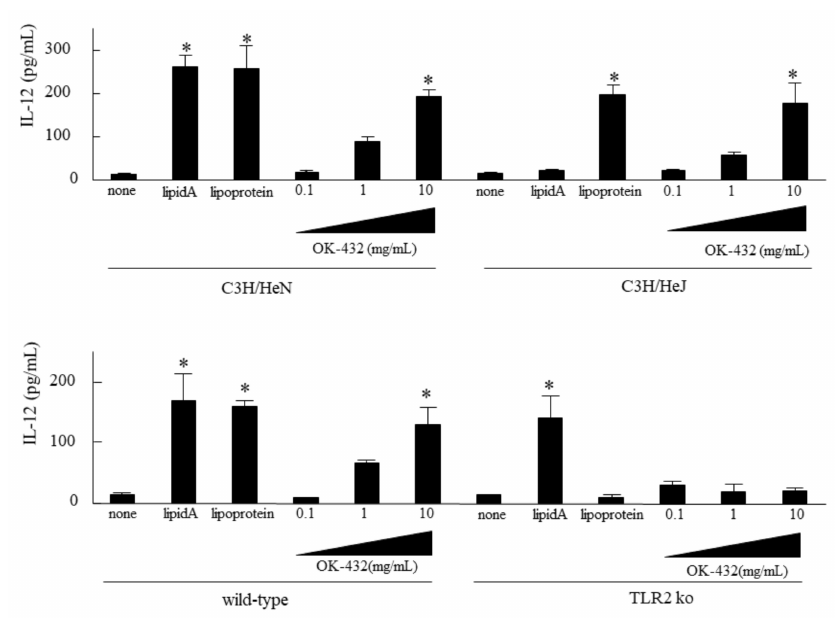
Figure 1. IL-12 production by splenic macrophages from C3H/HeN, C3H/HeJ, wild-type or TLR2 ko mice in response to OK-432. The macrophages from the spleen of C3H/HeN, C3H/HeJ, wild-type or TLR2 knock-out mice were cultured in the presence of lipid A, lipoprotein or OK-432 for 48 h at 37 ◦ C. IL -12 production by macrophages was measured by an ELISA. The data are representative of four independent experiments using pooled cells from five mice and are shown as the mean of triplicate determinations ± standard deviation (SD). *, p < 0.005.